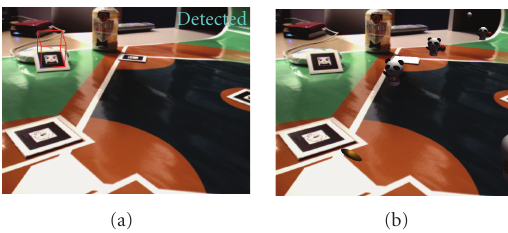
Figure 12: Most of the markers which face to the same directions as the tabletop cannot be detected. The marker which faces to di ff erent direction is detected successfully. (a) Marker detection: the red cube on the marker represents detected marker. (b) Augmented view: virtual objects are overlaid using the detected